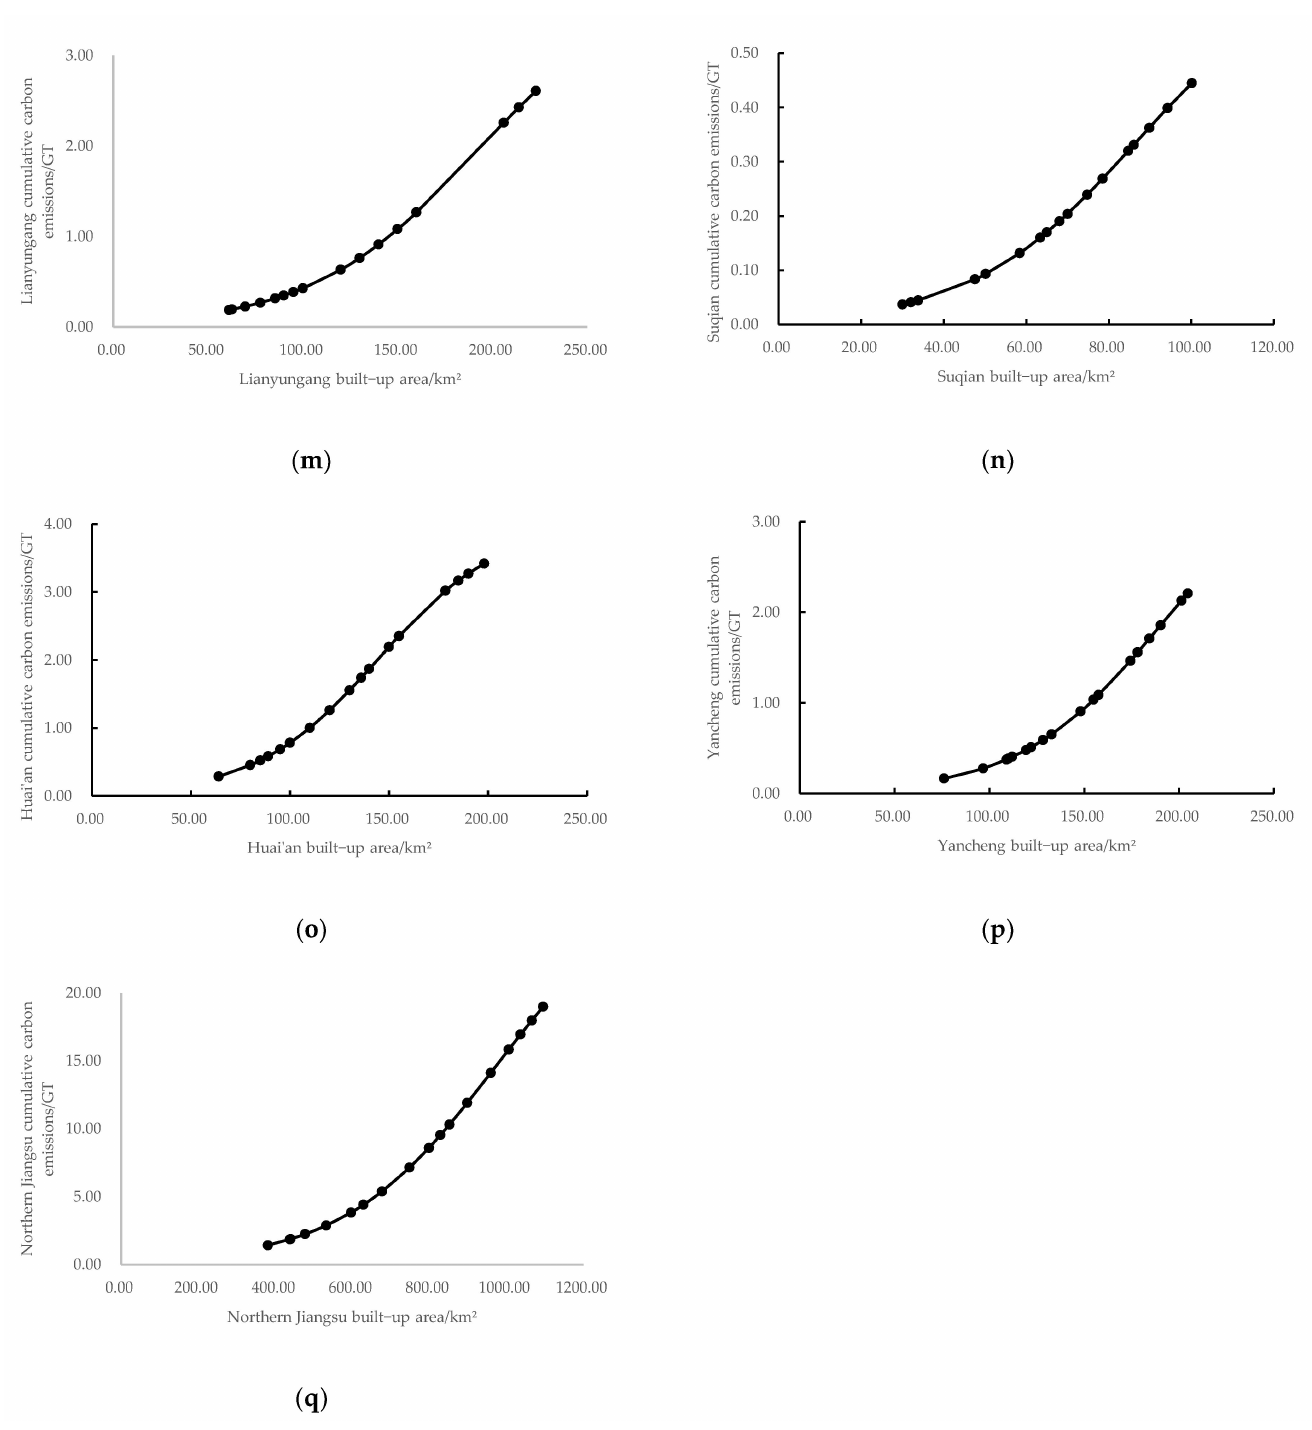
Figure 8. ( a – q ) are the logistic curves of Jiangsu Province, Southern Jiangsu, Central Jiangsu, Northern Jiangsu and 13 prefecture-level cities (GT stands for 100 million